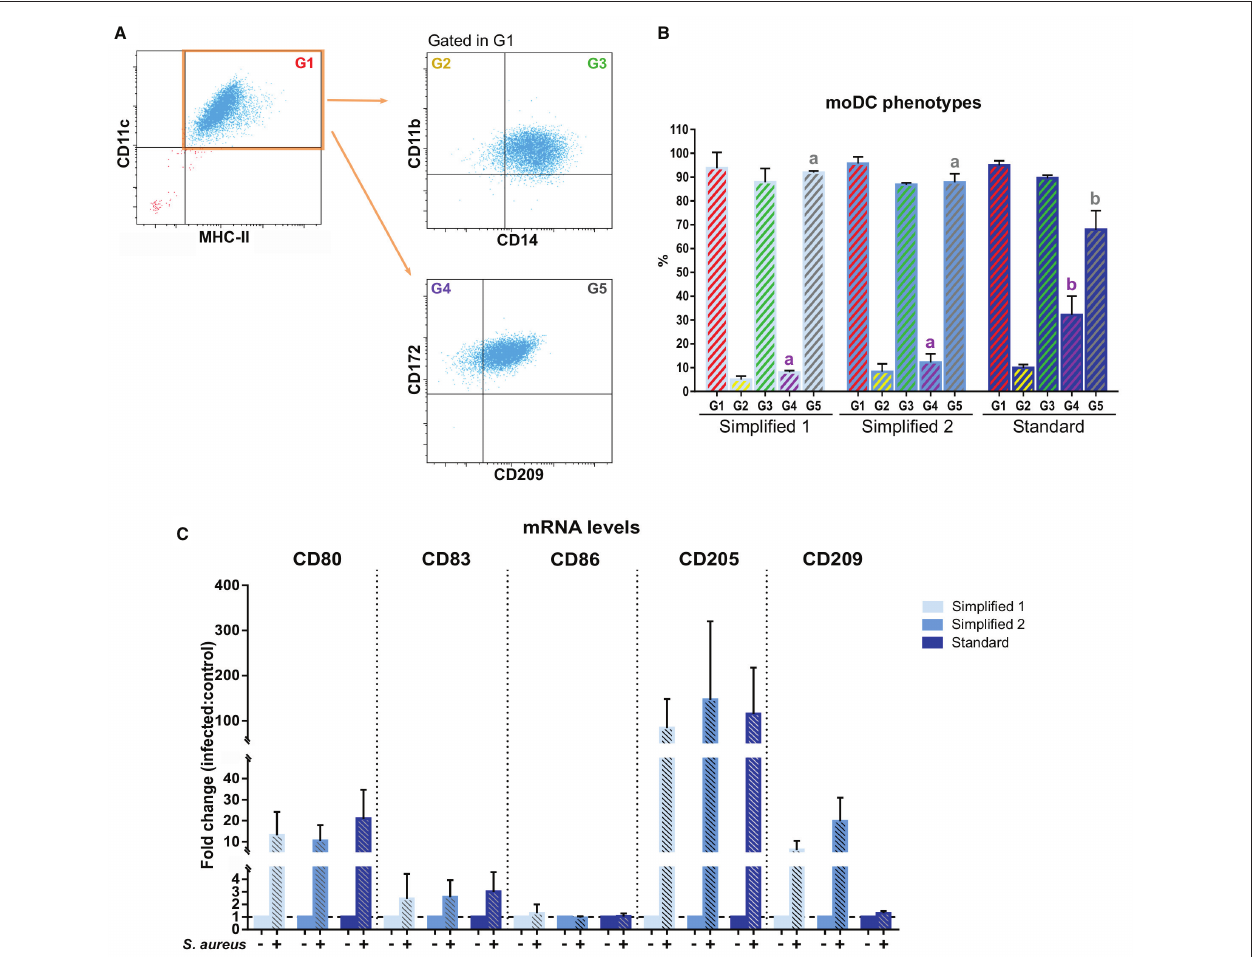
FIGURE 6 | Phenotype of bovine moDCs produced by 3 different approaches at day 9. (A) Analysis of surface markers by flow cytometry. The dot plots show the results of one representative experiment. Monolabeled and isotype controls are shown in Supplementary Figure 1B. (B) Bar plot depicts the percentage of cells in the gates indicated in (A) . Bars represent data from three independent samples. Different letters represent mean statistically significant difference ( p < 0.05). (C) CD80, CD83, CD86, CD205, and CD209 messenger RNA (mRNA) levels were analyzed after moDCs pulsing with a mastitis-causing Staphylococcus aureus ( S. aureus ) strain. Bars corresponding to non-treated controls are identified as S. aureus negative. Data from samples obtained from three different animals are shown as the fold change between the infected and control groups. Error bars represent